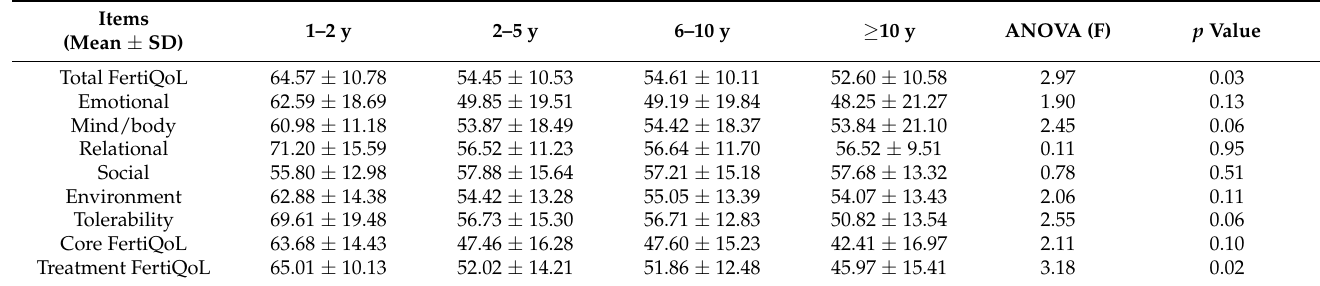
Table 6. Characteristics of average indicators of FertiQoL by duration of infertility.